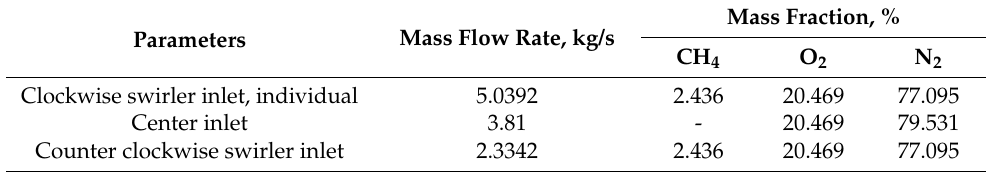
Table 1. Inlet boundary conditions for combustion simulation in